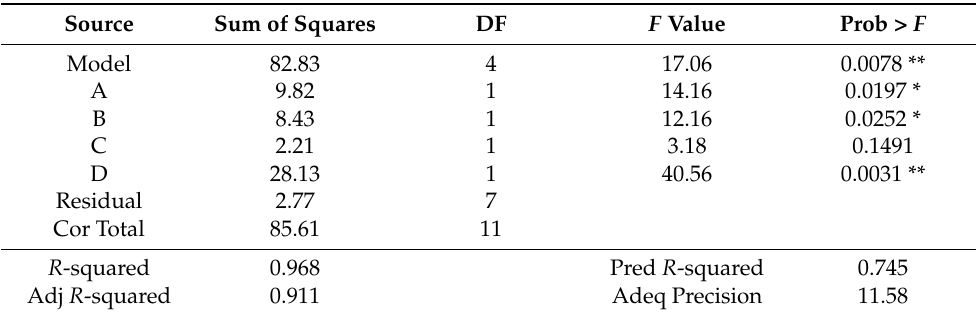
Table 5. Analysis of variance (ANOVA) for Plackett-Burman design for biosurfactant production using WCO as a substrate.